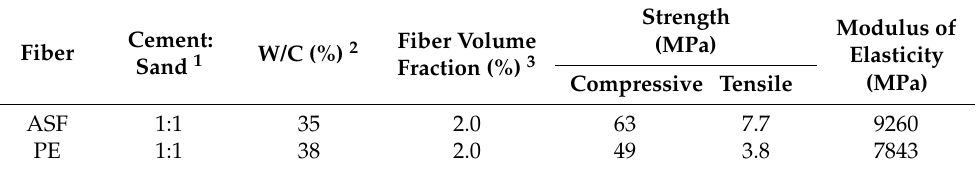
Table 3. Mixing ratio and properties of fiber reinforced mortar [22].